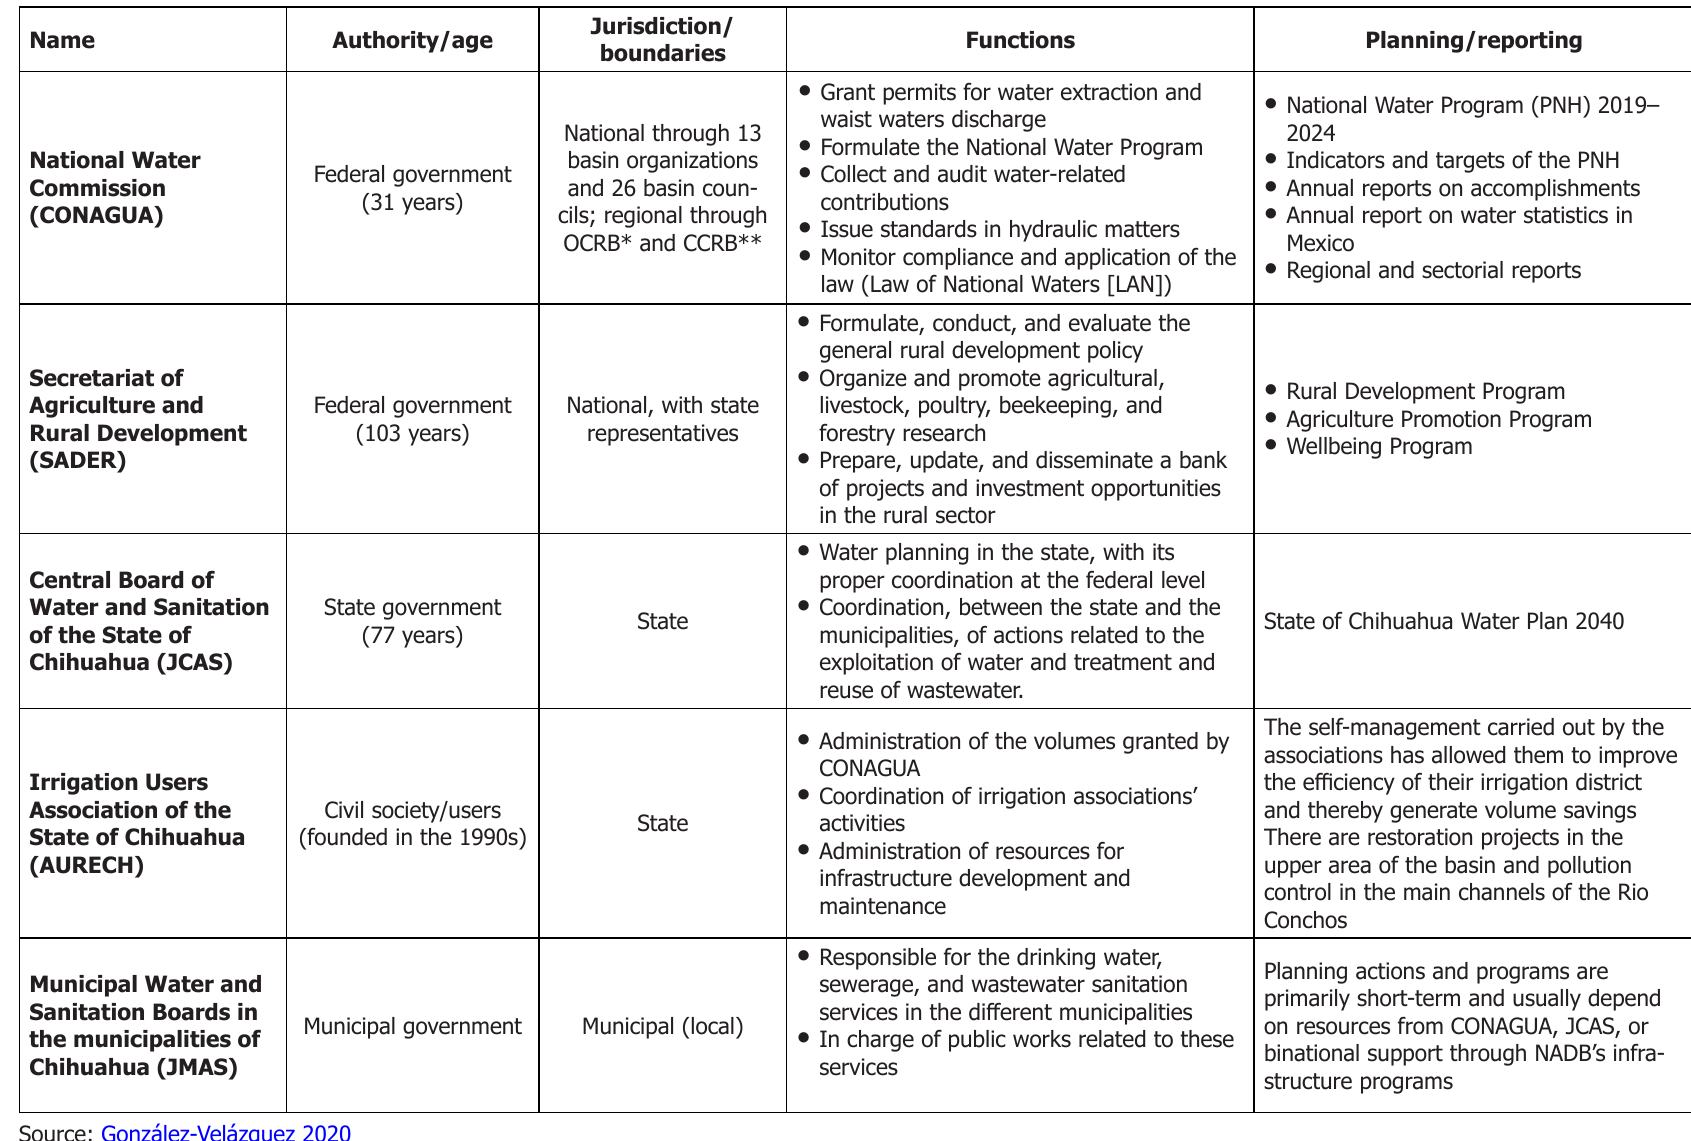
Table 7. Rio Conchos Watershed type I